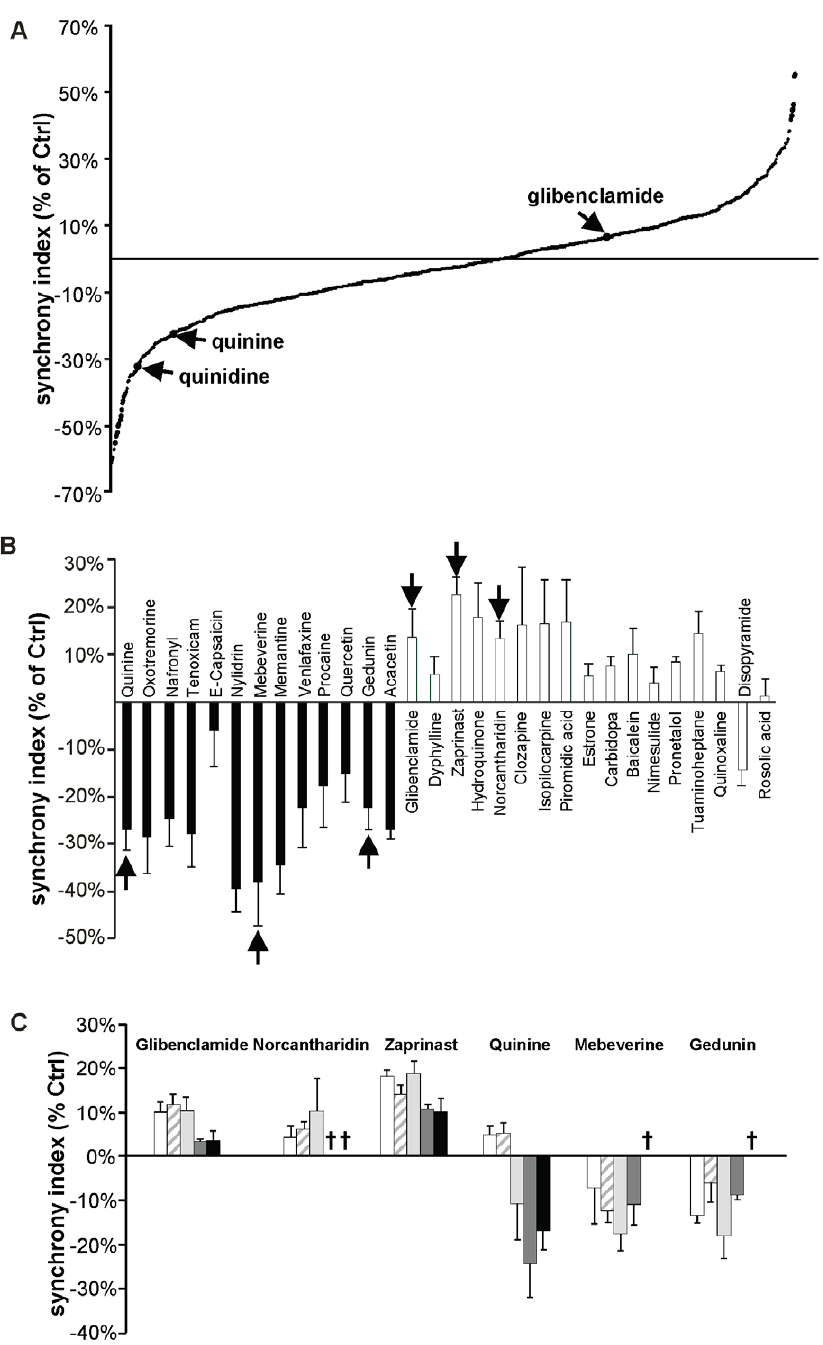
Figure 3. Primary and secondary screenings identify several molecules affecting the synchrony index of MIN6 cells. ( A ) The primary screening of 1040 compounds revealed that several molecules increased or decreased the synchrony index. Each point of the curve shows the percentage change in synchrony index induced by one drug, relative to the value evaluated in WT MIN6 cells exposed to DMSO, which was the vehicle of all compounds, and served as internal control. Of note, glibenclamide increased the synchrony index by , 12%, whereas quinine, and its stereoisomer quinidine, decreased it by 22 and 34%, respectively; ( B ) 17 drugs increasing ( white bars ) and 13 drugs decreasing the synchrony index ( black bars ) were repeatedly tested, and their effect on the synchrony index plotted relative to that of WT MIN6 cells exposed to DMSO. 97% of the drugs reproduced the effects observed in the primary screening. The six drugs pointed by the arrows were selected for further experiments. Data are means 6 SE of four independent experiments; ( C ) Dose-response experiments were conducted with the six selected drugs. The effect of these drugs on the synchrony index was plotted relative to that of WT MIN6 cells exposed to DMSO. The effects on the synchrony index varied with the concentration tested. Glibenclamide, norcantharidin and zaprinast increased the synchrony index for concentrations # 10 m M, whereas quinine, mebeverine and gedunin decreased it. Several drugs showed cytotoxicity at concentrations . 10 m M. All drugs were tested at the following concentrations: 0.1 m M, 1 m M, 10 m M, 50 m M and 100 m M. ‘‘ { ’’ indicates concentrations toxic for MIN6 cells, as evaluated by cell detachment from the support. Data are means 6 SE of at least four independent experiments.